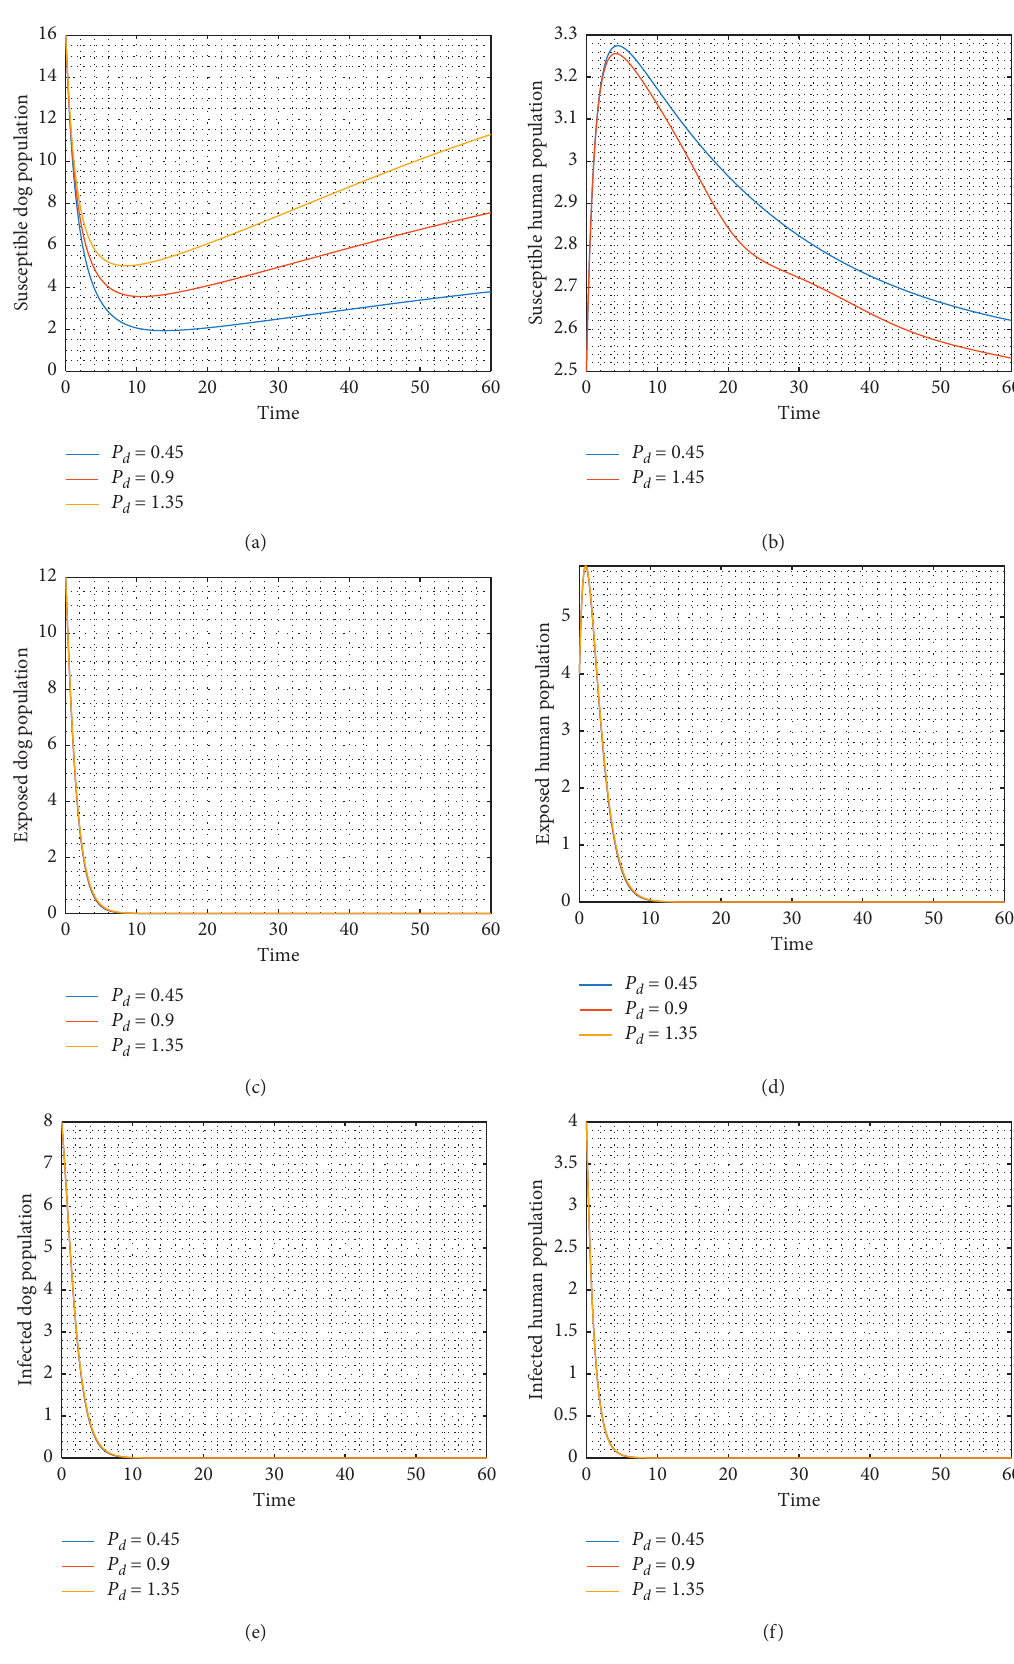
Figure 8: Solution curves of model (1) showing the effect of P